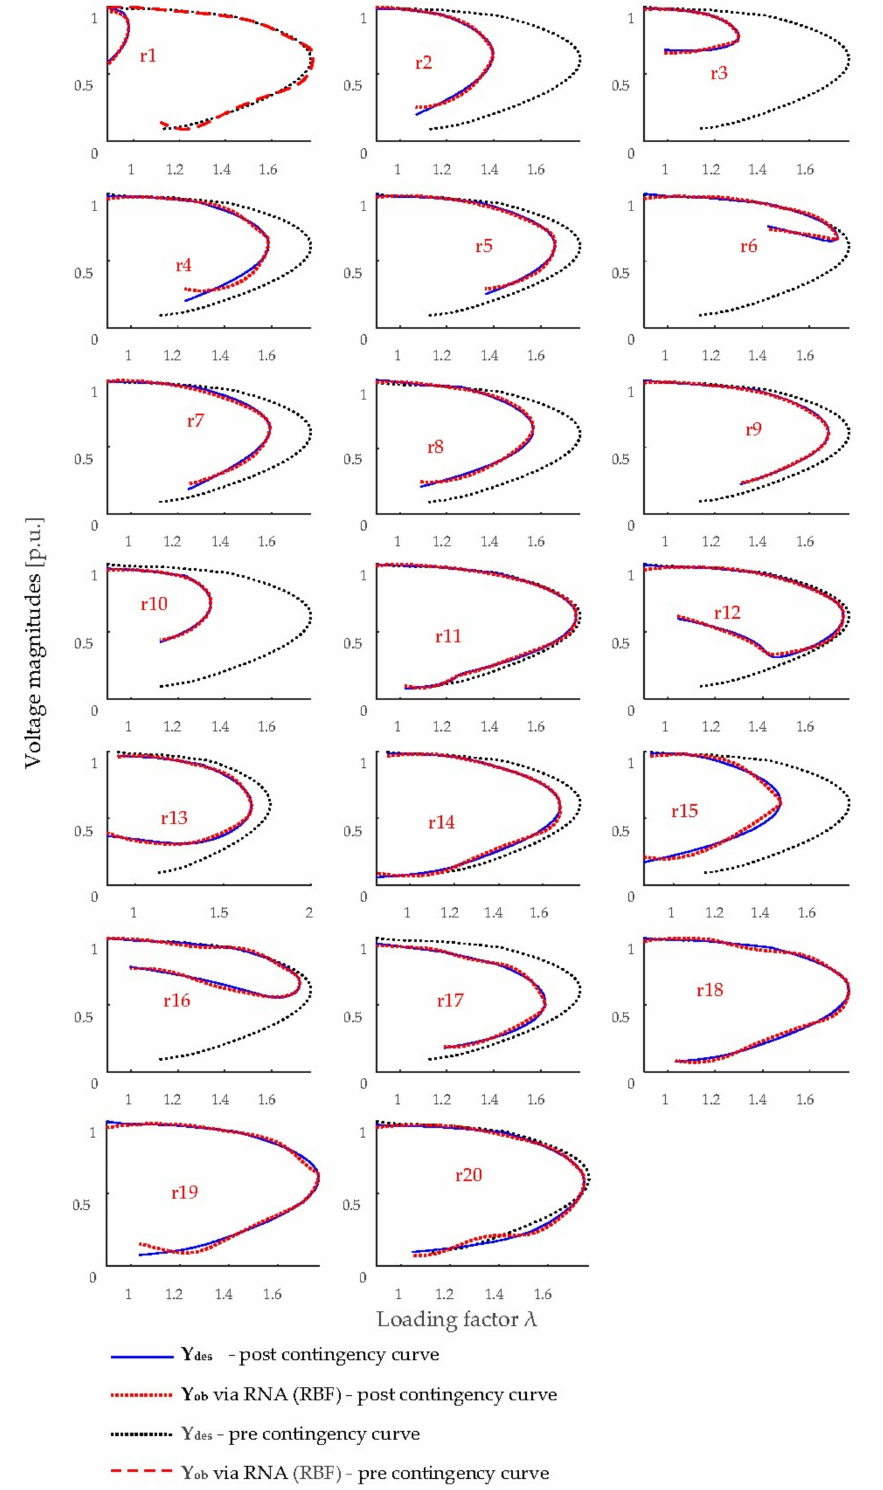
Figure 8. Desired output ( Y des ) and obtained output ( Y ob ) by the RBF network, P-V curves for all contingencies r of the system for bus